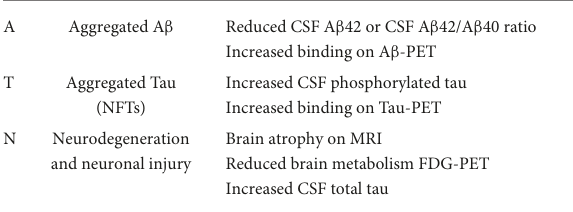
TABLE 1 ATN biomarker classification was established by Jack et al.